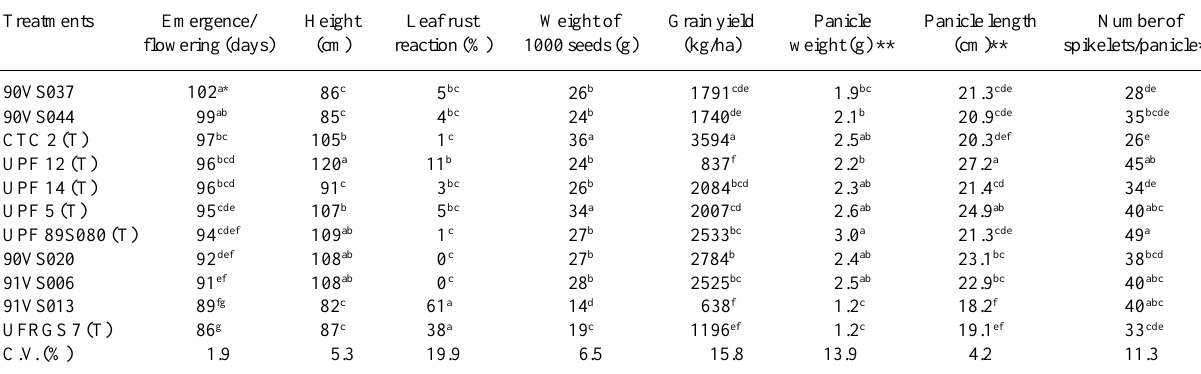
Table II - Comparison of means from oat somaclones derived from line UPF 89S080 and controls for the following characteristics: days between emergence and flowering, plant height, leaf rust reaction, weight of a thousand seeds, grain yield, panicle weight and